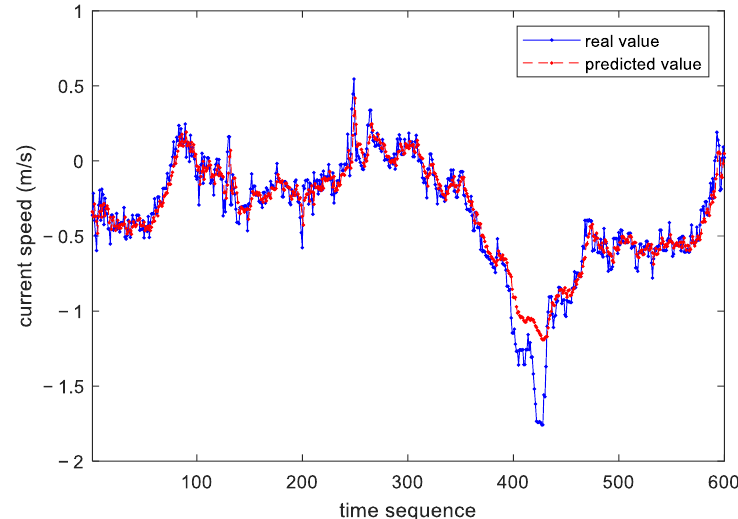
Figure 4. Prediction results of wind speed.